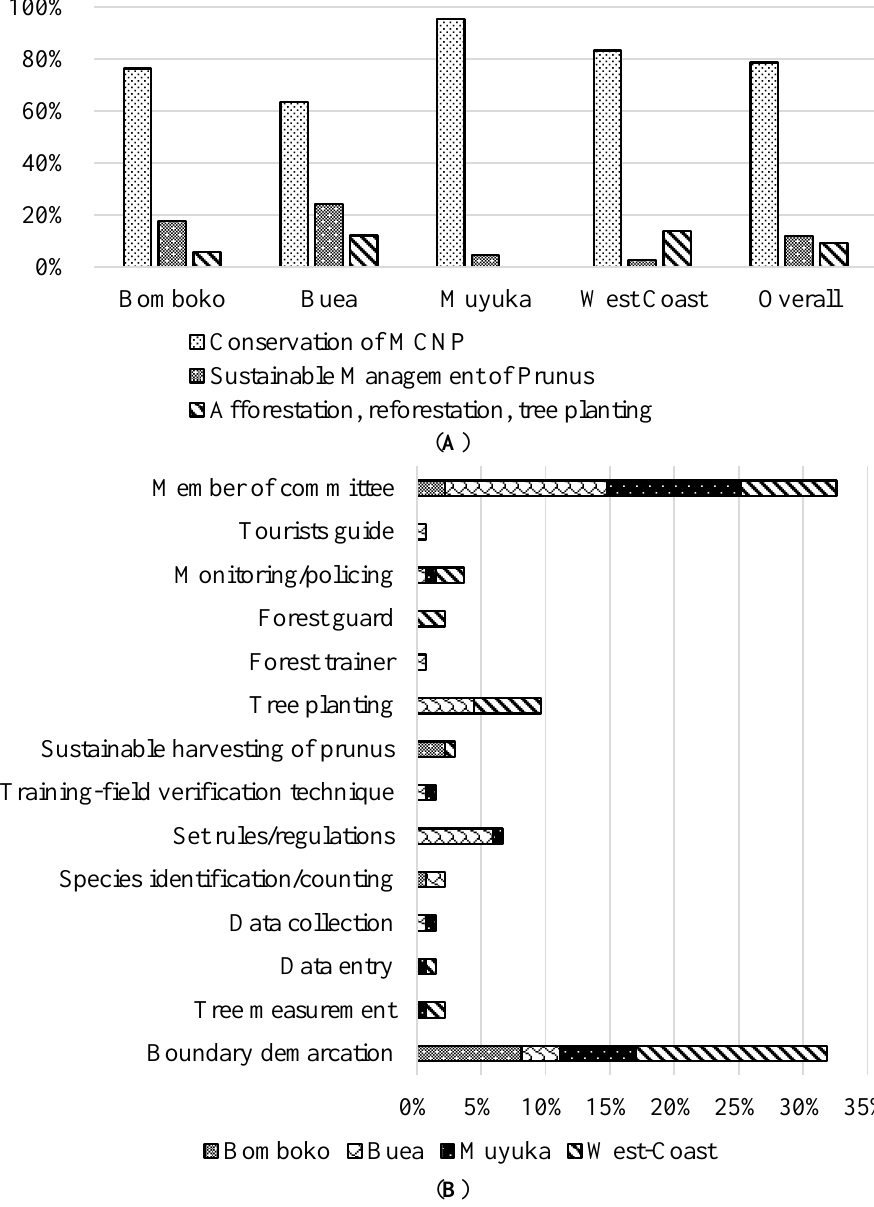
Figure 10. Percentages of different projects participated in ( A ) and function/role carried out ( B ) by participants within all clusters.